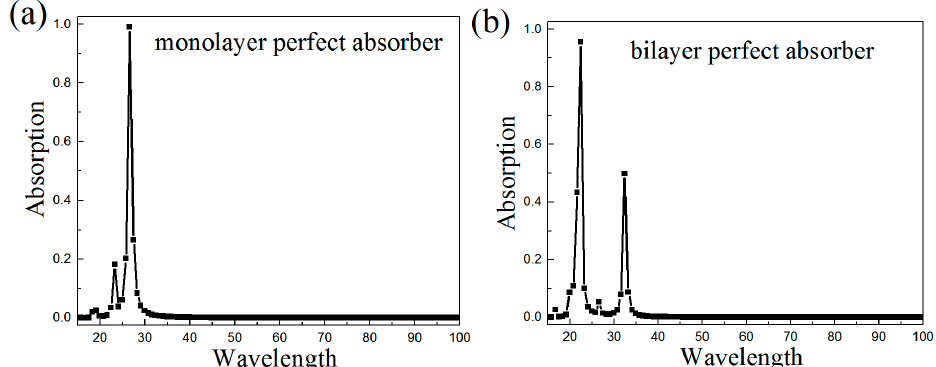
Figure A1. ( a ) The monolayer perfect absorption of this structure, ( b ) The bilayer perfect absorption of